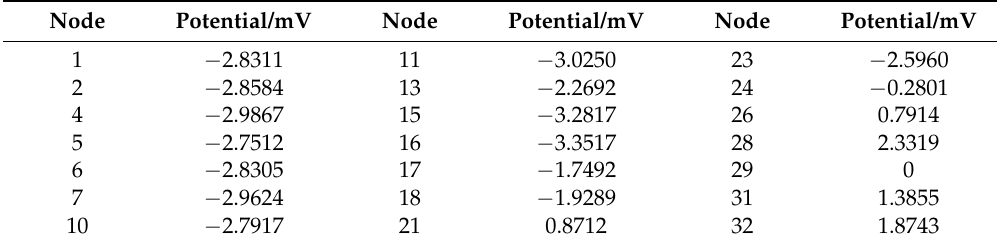
Table 2. A part of the measurements.